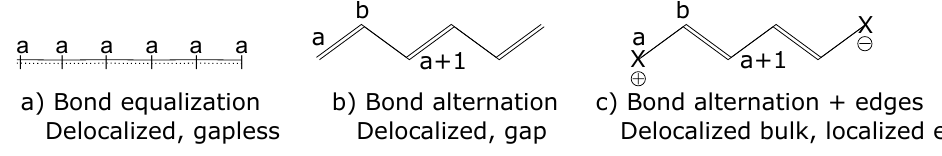
Figure 1. Chemical representation of the resonance forms of interest in